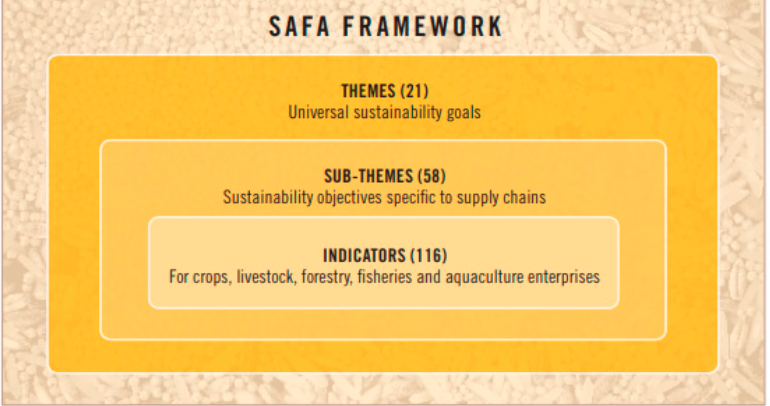
Figure 4. SAFA structure and division into themes, sub-themes and indicators. Source: SAFA guideline.